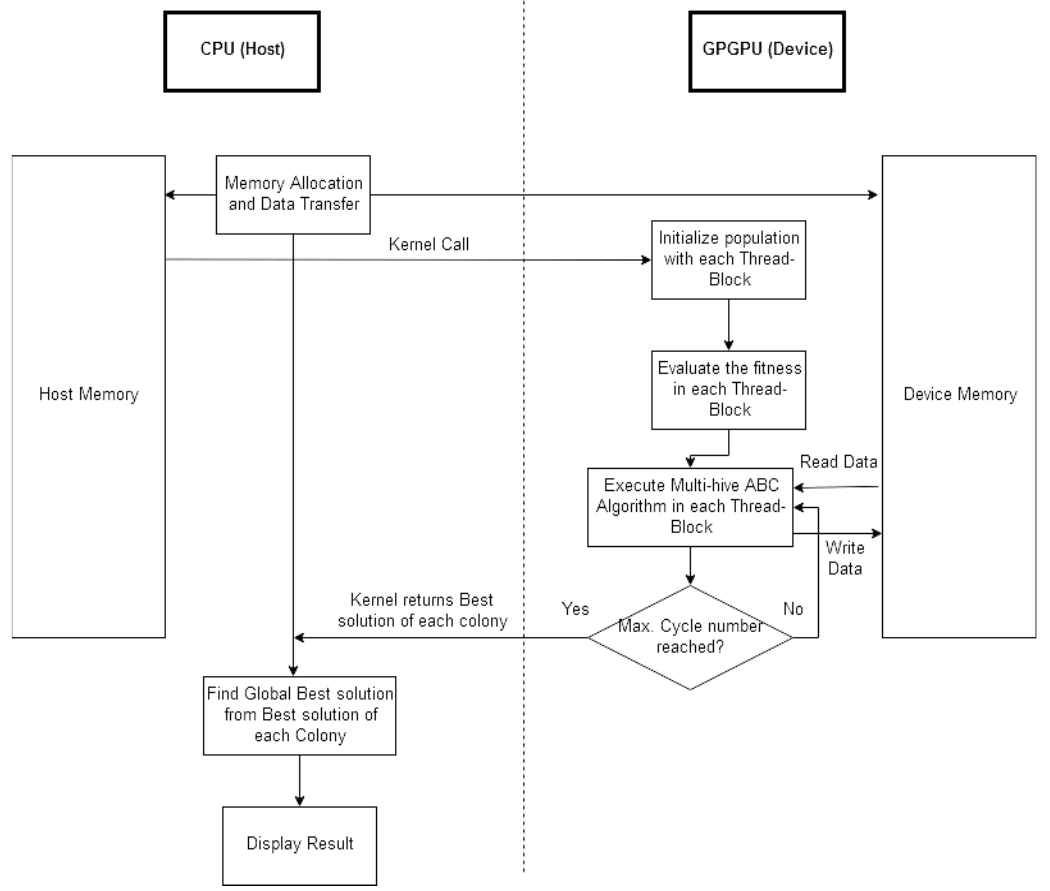
Figure 1. Flow of Proposed GPGPU based Multi-hive ABC